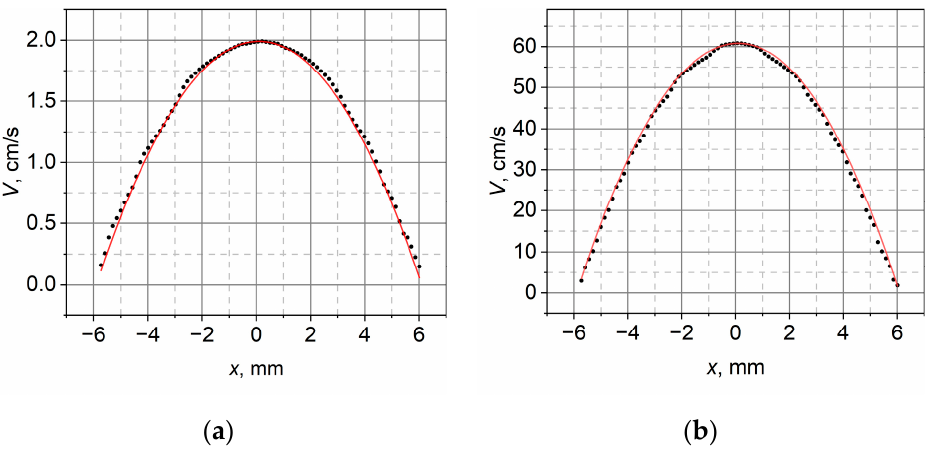
Figure 4. Velocity profile for setpoint: ( a ) 𝑉 (cid:3028)(cid:3049)(cid:3034)(cid:3014) = 1.1 cm/s and ( b ) 𝑉 (cid:3028)(cid:3049)(cid:3034)(cid:3014) = 31.27 cm/s .